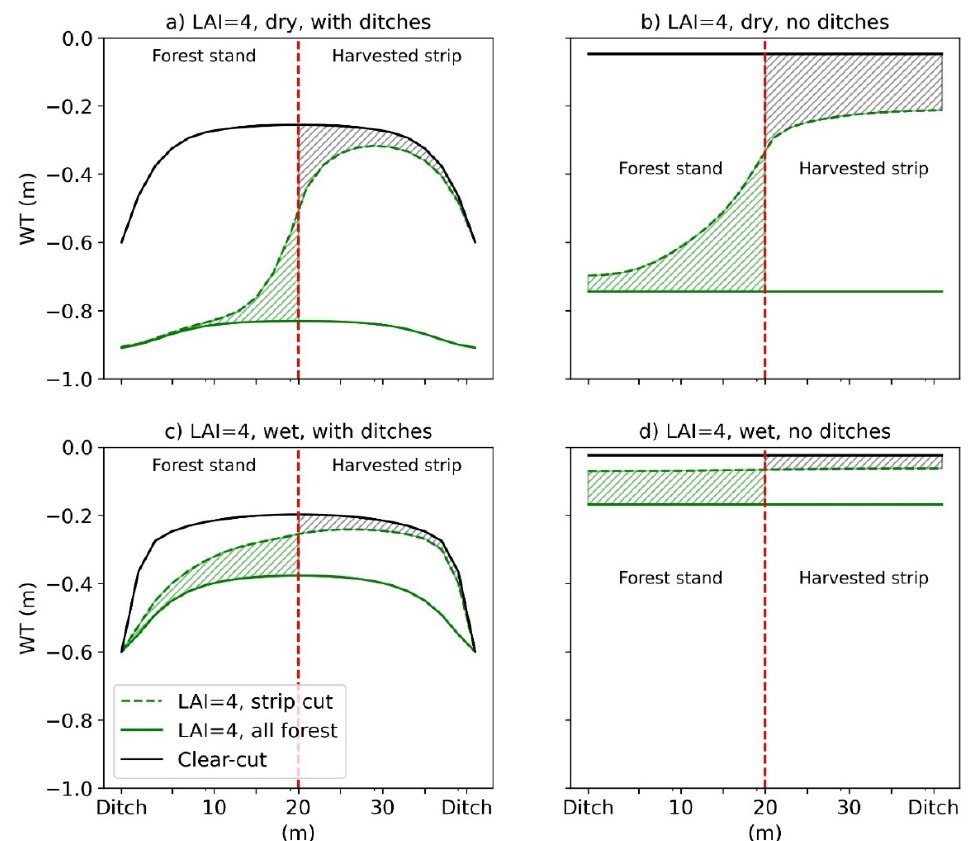
Figure A3. Cross-sectional, momentary simulated WT at the end of August during a dry ( a , b ) and wet ( c , d ) growing season in a Sphagnum peat area with ditches (depth: − 0.6 m) ( a , c ) and without ditches ( b , d ). The edge between the forest stand and the harvested strip is separated with red, dashed lines. Green hatched areas indicate the edge effect of the harvested strip on the forest stand. The gray hatched areas indicate the edge effect of the forest stand on the harvested strip.